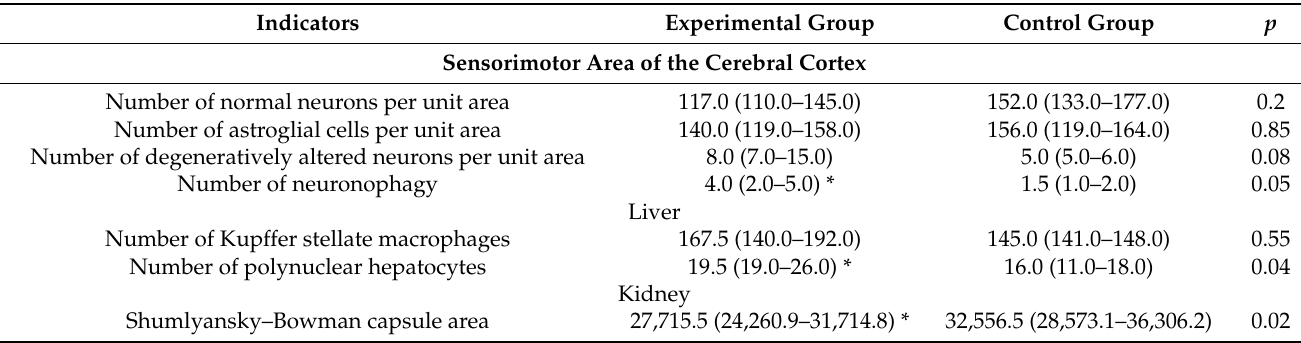
Table 2. Morphometric parameters of the sensorimotor zone of the cerebral cortex, liver and kidney tissues during subacute administration of the Ag 2 Se-AG nanocomposite to rats at a dose of 500 µ g/kg of body weight for 10 days. Me